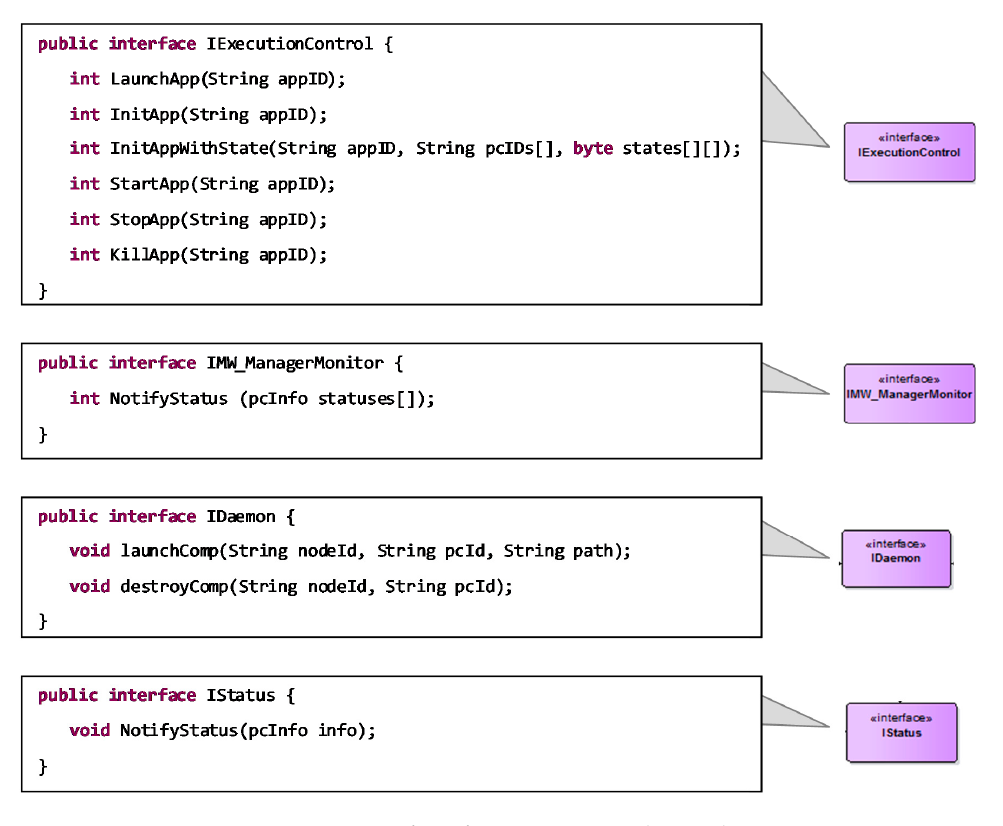
Figure 7 . Interfaces for monitoring and control. Figure 7. Interfaces for monitoring and